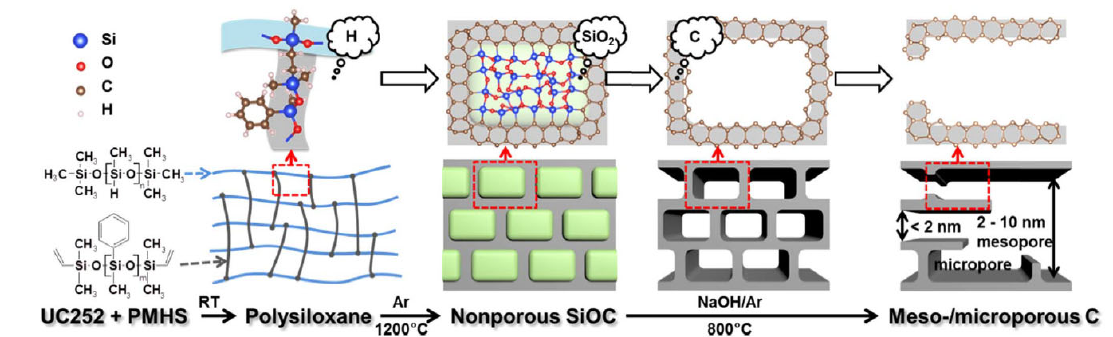
Fig. 27 Synthesis of polysiloxane-derived highly mesoporous carbon via NaOH etching and activation. Reproduced with permission from Ref. [523], © Elsevier Ltd.